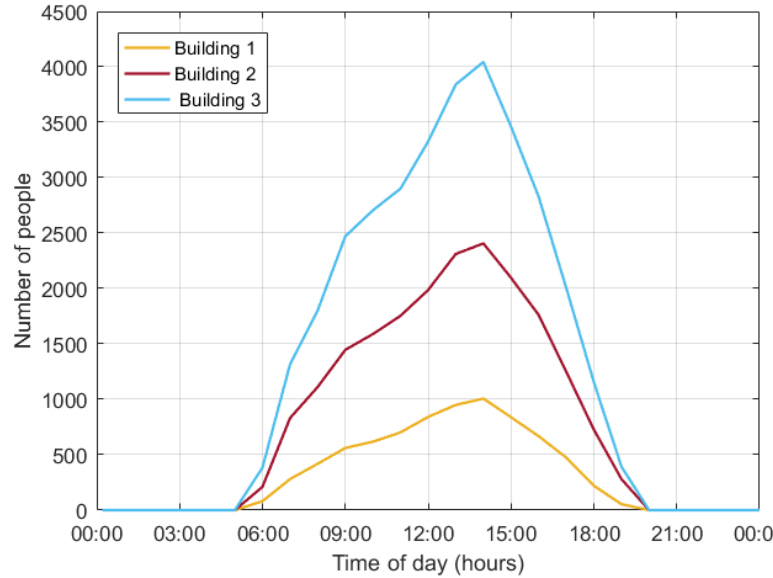
Figure 6. Forecasted number of active people in microgrid’s building. The connection and the dwell periods of the PEVs rely on the different types of activities (being at home, being at work, shopping and social engagements) that their drivers partake in and they are calculated using their respective probability density functions (PDFs) [32], as are shown in Figure 7a and Figure 7b, respectively. For instance, as it can be observed, the connection rate for the PEVs of citizens who are at work peaked at 7:30 a.m., whereas their dwell time peaked at approximately 8.5 h. The obtained total number of the connected EVs that were found during the examined time period is shown in Figure 8.